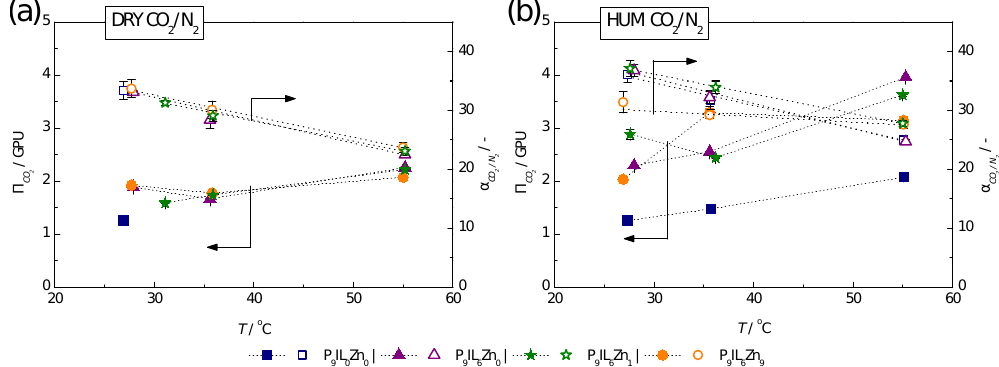
Figure 9. Influence of the temperature on the separation performance of PIL/IL/Zn 2+ composite-based TFC membrane at 26 ◦ C, 35 ◦ C and 55 ◦ C and 1.2bar in dry ( a ) and humidified ( b ) conditions of the sweep test set-up. The relative humidity of feed gas was ca. 90% for humidified